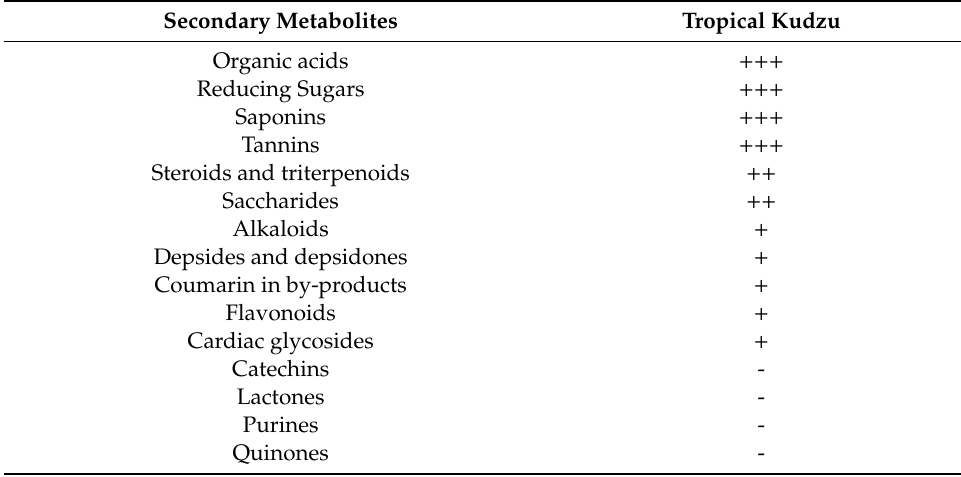
Table 8. Summary of qualitative tests from phytochemical screening and analysis of kudzu ( Pueraria phaseoloides )